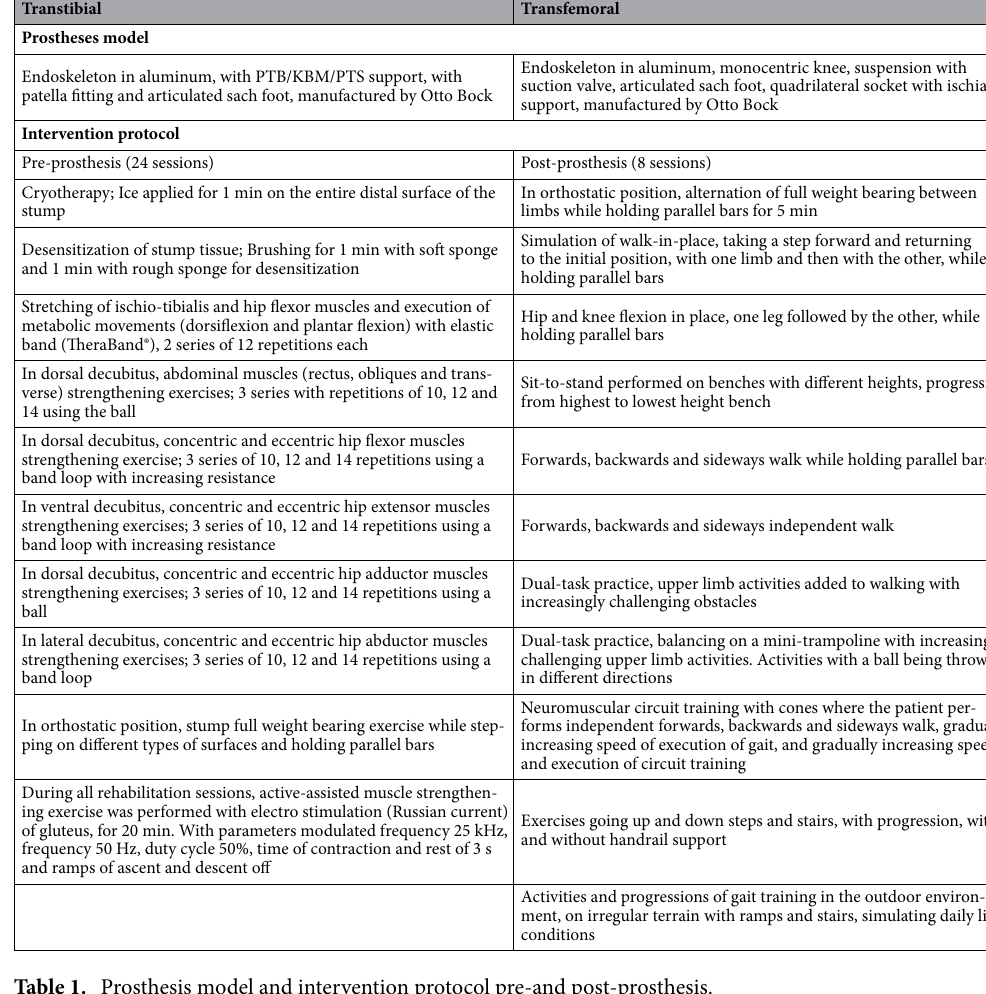
Table 1. Prosthesis model and intervention protocol pre-and